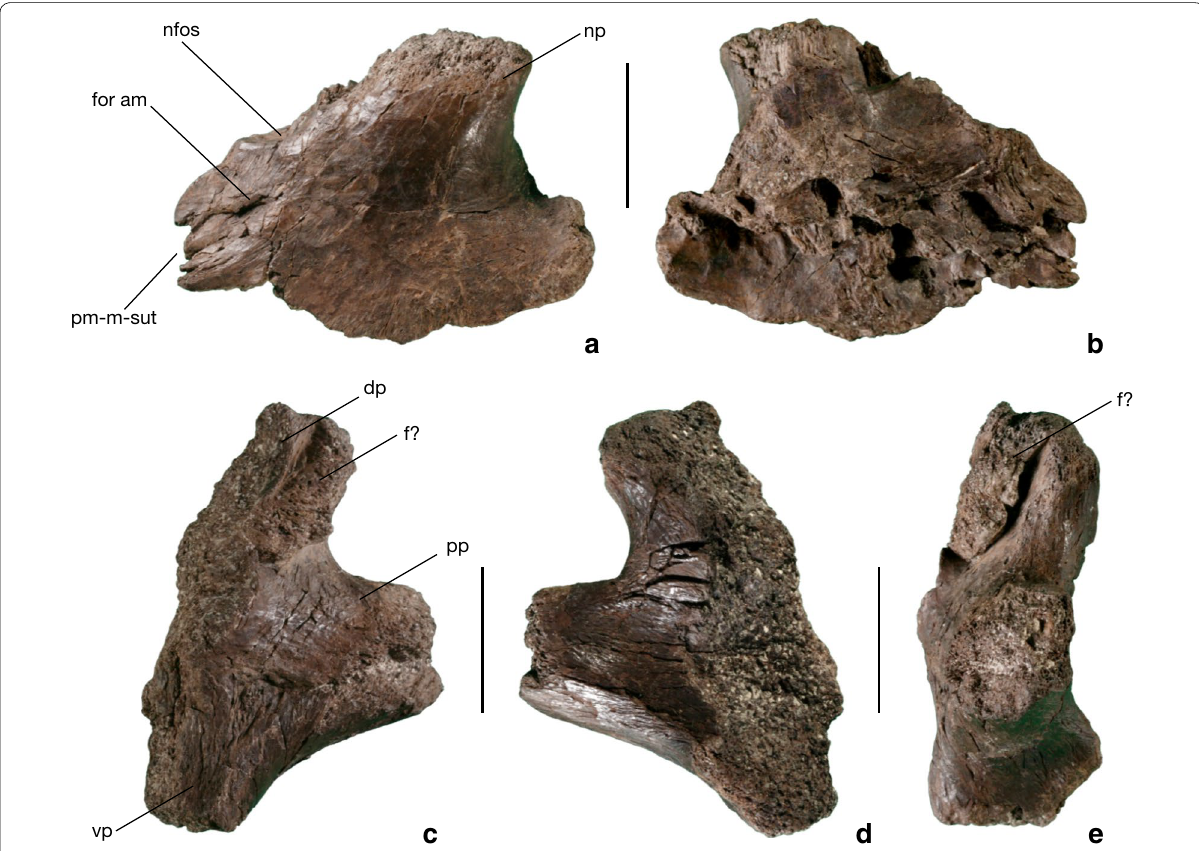
Fig. 2 Skull fragments of A. greppini . NMB M.H. 301, left maxilla in a lateral and b medial aspect. NMB M.H. 313, tentatively assigned left postorbital in c lateral, d medial and e posterior aspect. Scale bar is 20 mm. dp dorsal process, f frontal (determination questionable), for am anterior maxillary foramen, nfos narial fossa, np narial process, pm-m-sut premaxillo-maxillary suture, pp posterior process, vp ventral